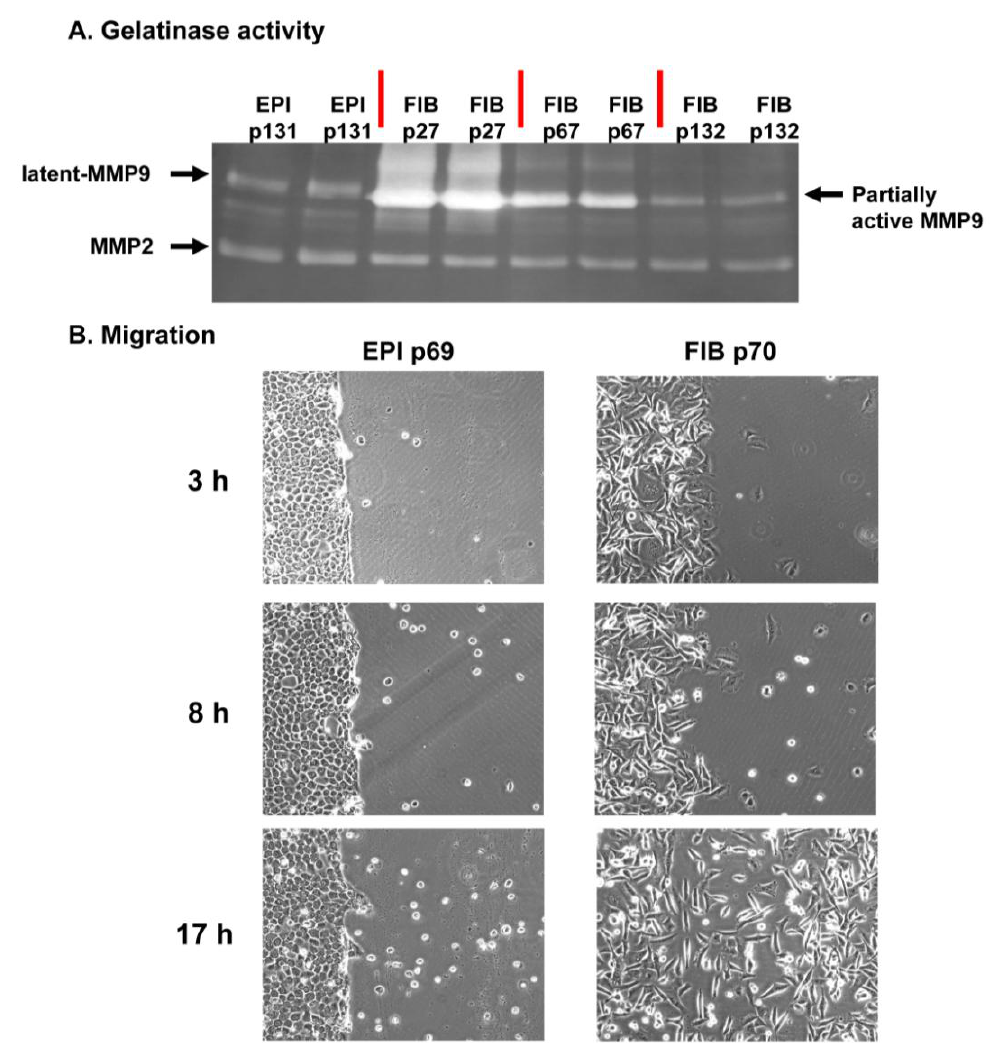
FIGURE 4. Cellular motility of EPI and FIB cells. (A) Gelatinase activity of EPI and FIB cells in conditioned medium after culture for 24 h. FIB cells released partially active MMP-9, while EPI cells released latent MMP-9. (B) In wound assay, FIB cells were more migratory than EPI